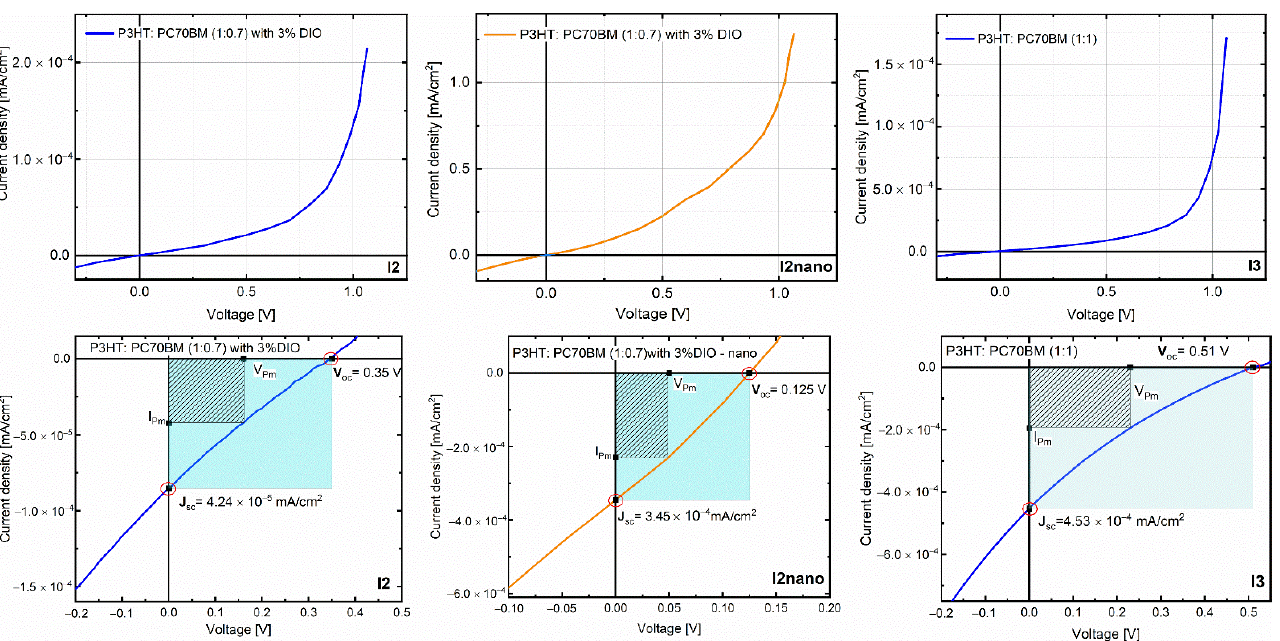
Figure 9. J-V characteristics of the structures based on MAPLE-deposited organic layers on ITO and ITO micro-patterned electrodes under dark conditions and solar illumination.